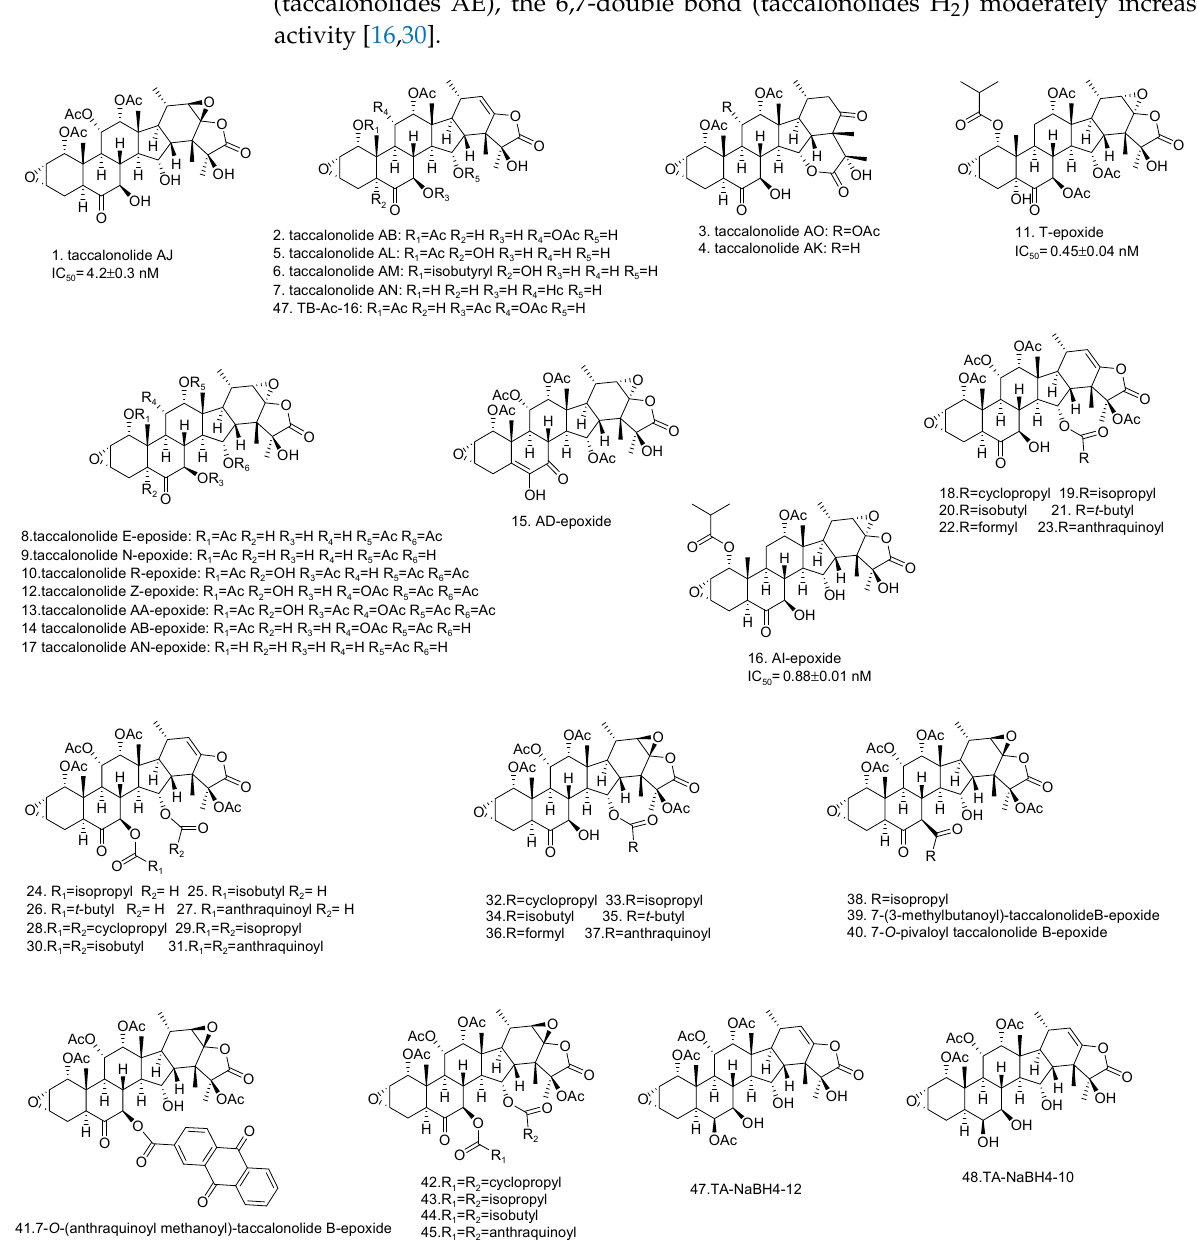
Figure 4. The structures of semi-synthetic taccalonolides (1–48).